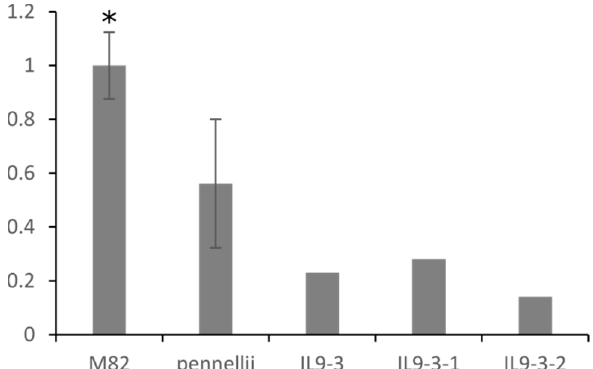
Figure 5. Transcript level of class III lipase ( Solyc09g091050 ) in red ripe fruits of M82, Solanum pennellii , IL 9-3, IL 9-3-1, IL 9-3-2. Expression of the gene in wild tomato species Solanum pennellii as well as in ILs carrying the same allele version is lower in comparison to cultivated tomato variety M82. Asterisks indicate significant differences ( ∗ p < 0.05, ∗∗ p < 0.01, ∗∗∗ p < 0.001).